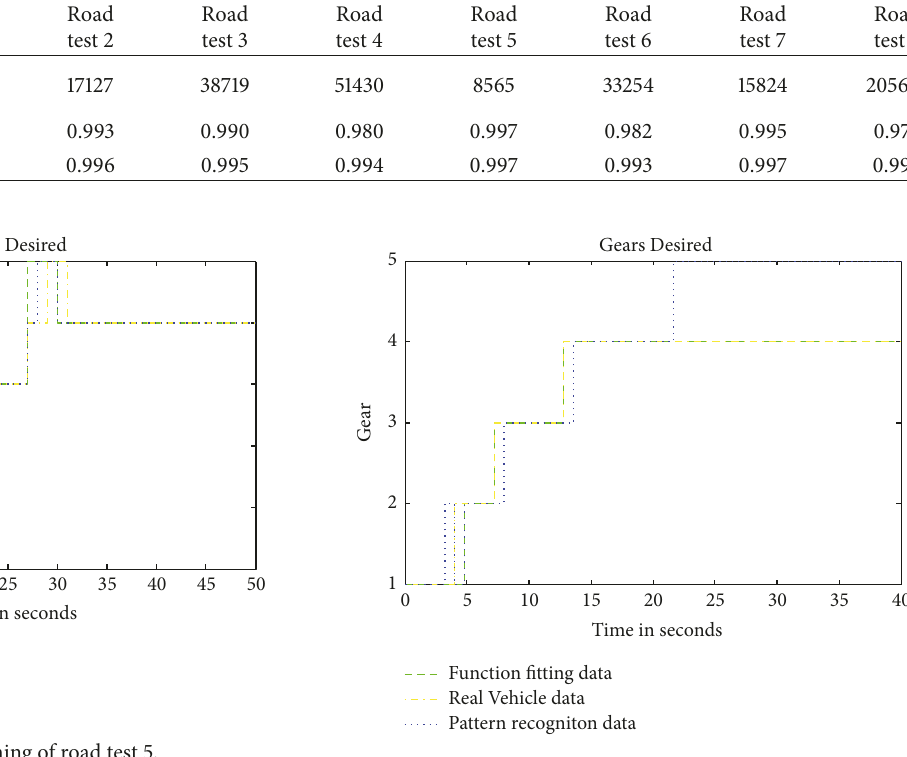
Figure 27: Gear timing of road test